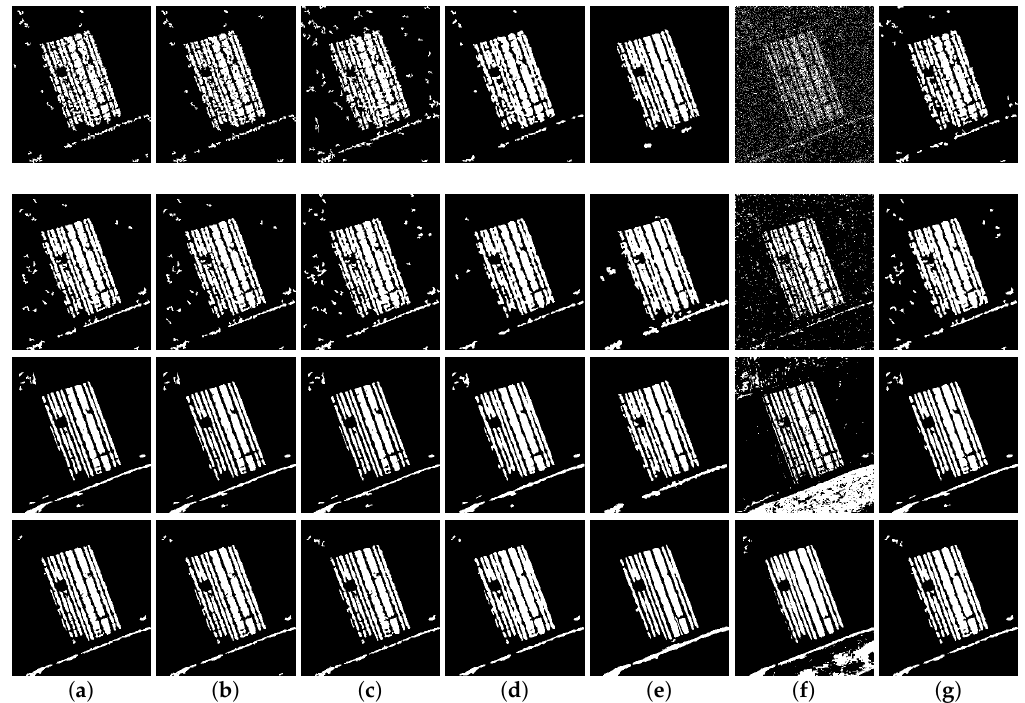
Figure 9. Results of ( a ) PCAK, ( b ) SPC, ( c ) FCM-MRF, ( d ) GTLC, ( e ) SACD, ( f ) Conradsen, and ( g ) SC-SGD on the Yellow River A dataset. From top to bottom: each row contains the results of the input image, and images filtered by MMSE, SAR-BM3D, and PPB filters, respectively.